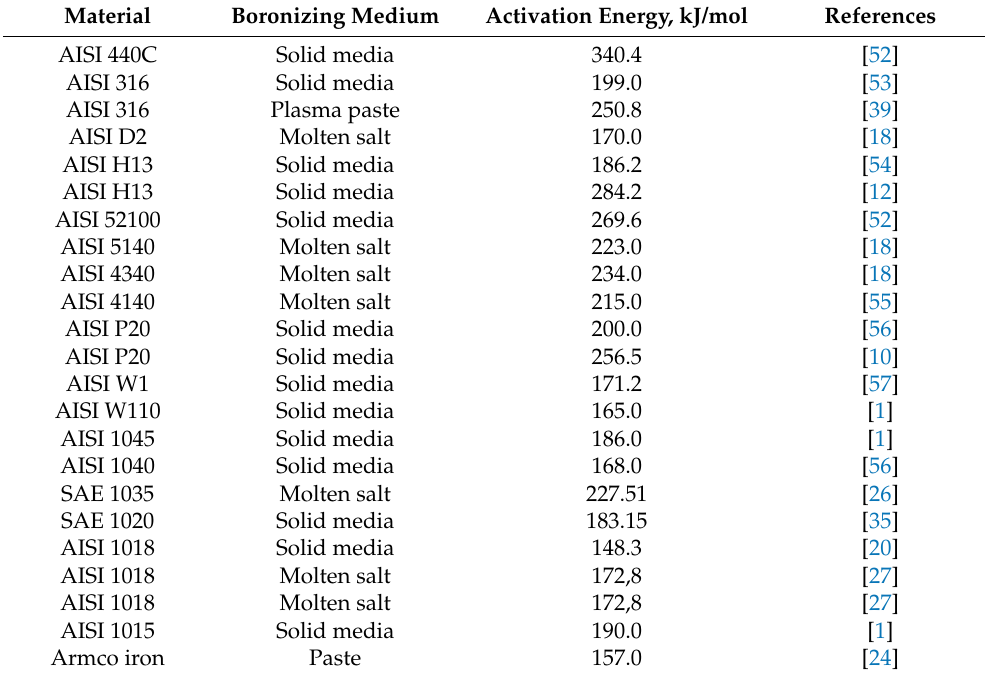
Table 6. Comparison of the activation